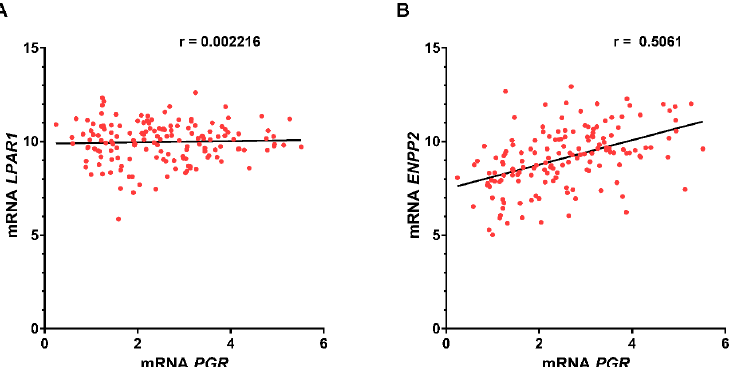
Figure 8. Correlation between LPAR1/PGR and ENPP2/PGR expression in GBM. The Spearman correlation coefficient was calculated to measure the association between ( A ) LPAR1/PGR and ( B ) ENPP2/PGR in GBM samples from the TCGA database .